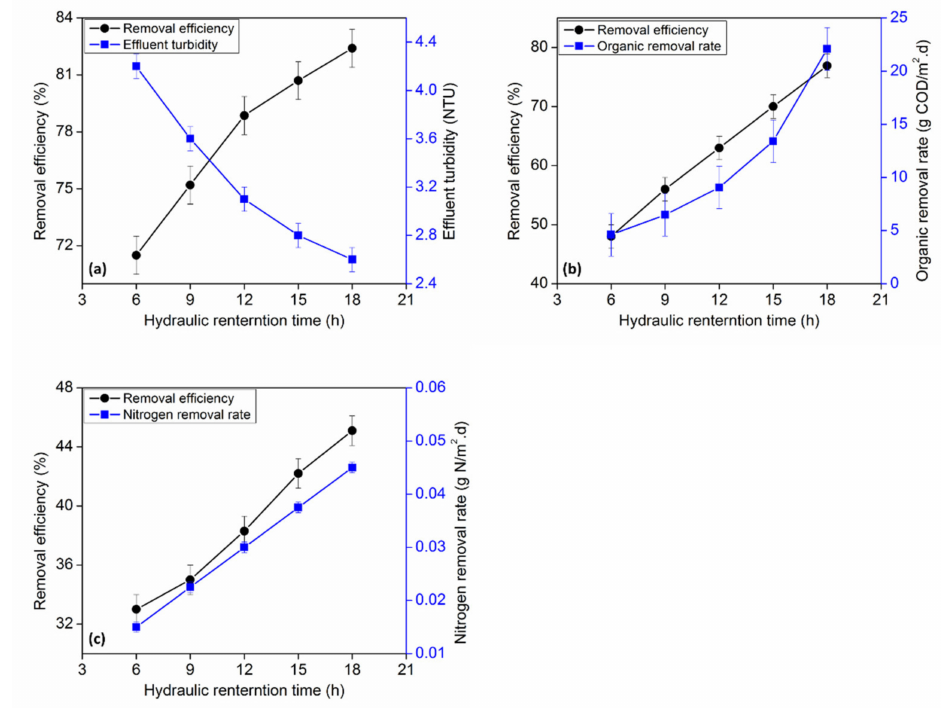
Figure 6. Effect of hydraulic retention time on ( a ) turbidity, ( b ) COD, and ( c ) TN